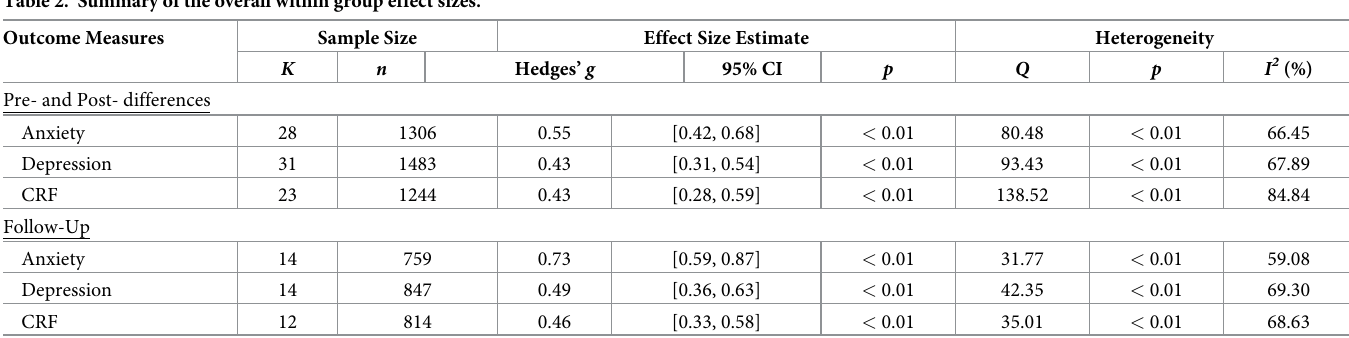
Table 2. Summary of the overall within group effect